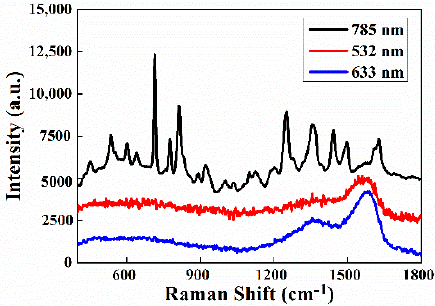
Figure 9. Sandwich-structure-based SERS spectra of MDA(100 µ g/mL) solution under different excitation lasers.